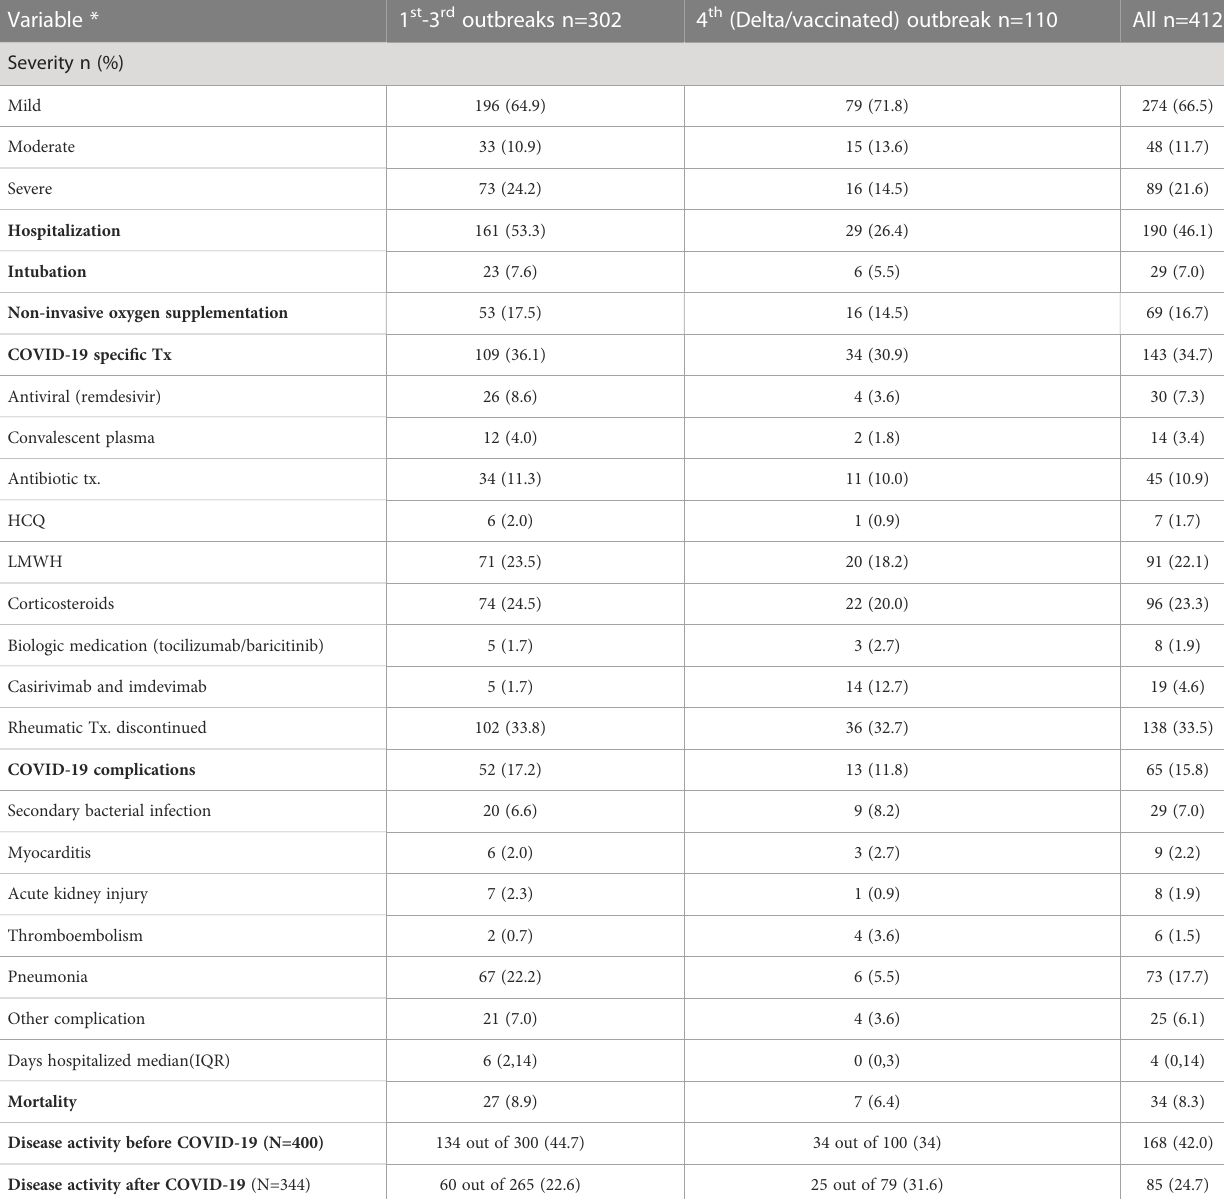
TABLE 2 COVID-19 course, treatment and complications in Israeli AIIRD